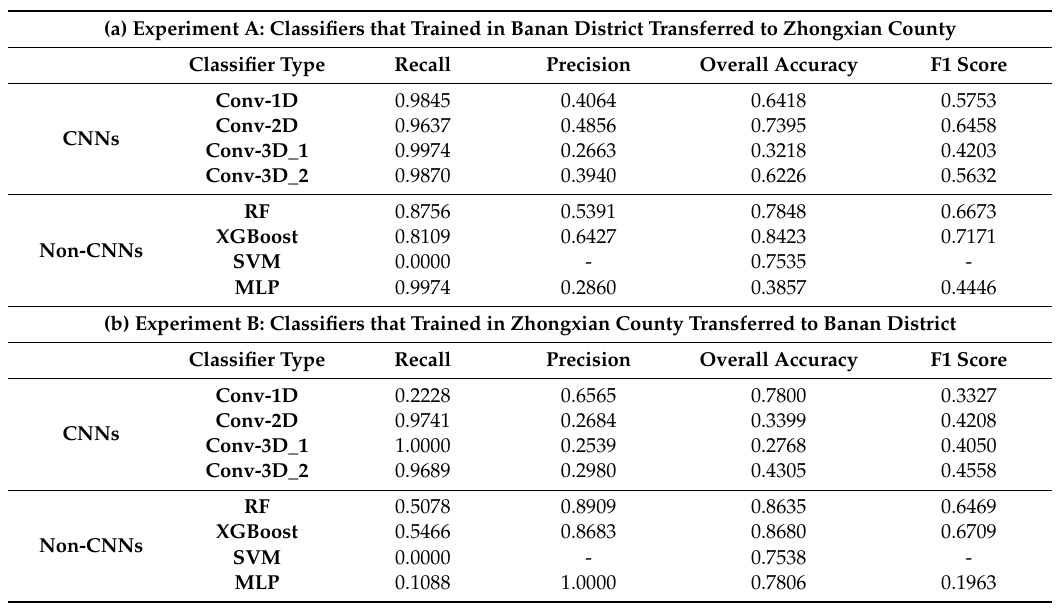
Table 5. Classifiers transfer accuracy evaluation in Experiment A and Experiment